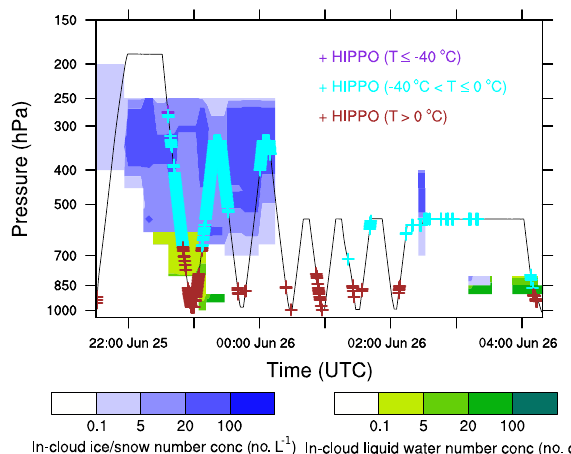
Figure 1. Cloud occurrences simulated by CAM5 (blue and green shaded areas) compared with HIPPO observations (crosses) dur- ing HIPPO#4 research flight 05 (H4RF05) from Rarotonga, the Cook Islands (21.2 ◦ S, 159.77 ◦ W), to Christchurch, New Zealand (43.48 ◦ S, 172.54 ◦ E), on 25–26 June 2011. Modeled in-cloud ice crystal number concentration and cloud droplet number concentra- tion are denoted by blue and green shaded areas, respectively. Three temperature ranges are used to categorize the combined measure- ments of 2DC and CDP probes. The criteria for defining observed cloud occurrences are described in Sect.